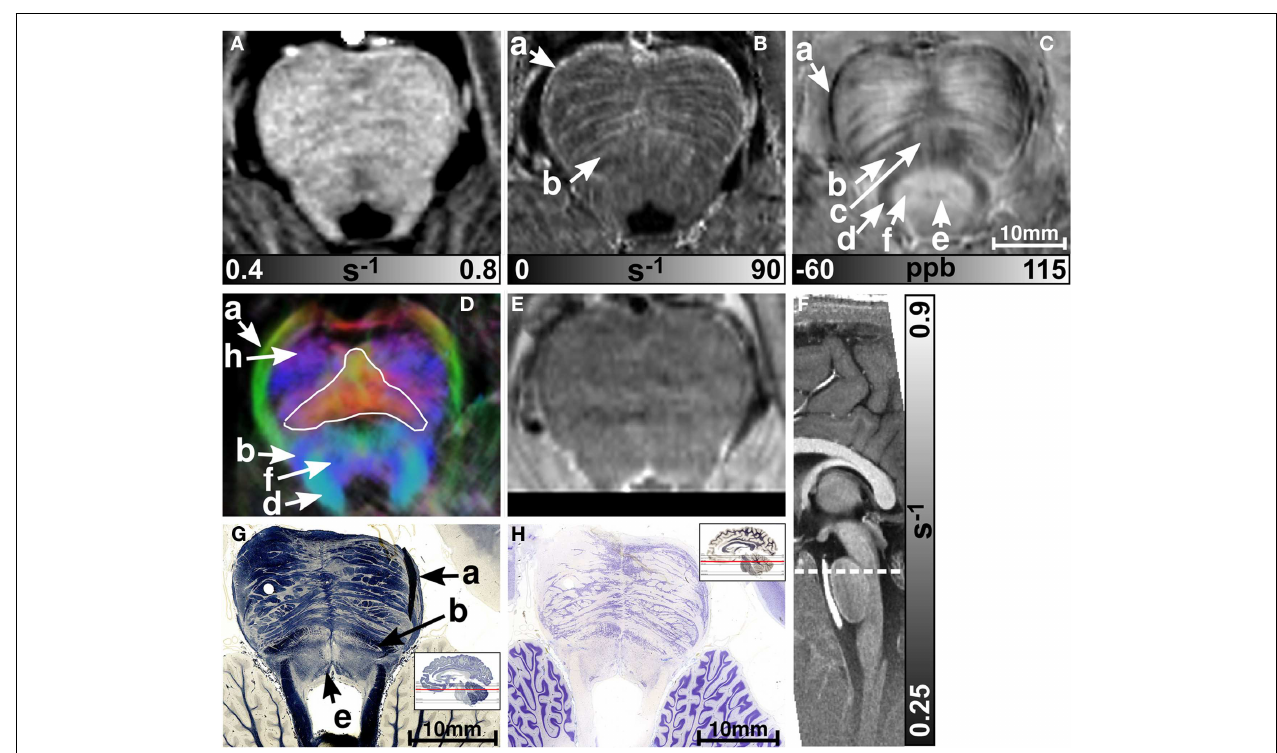
illustrated in (G) and (H) , respectively.The arrows in the images indicate: , and susceptibility FIGURE 3 | Images of the rostral part of the pons . R 1 , R ∗ 2 (a) middle cerebellar peduncle, (b) medial lemniscus, (c) reticulotegmental maps as well as direction-encoded track-density (same color-encoding as in nucleus, (d) superior cerebellar peduncle, (e) medial longitudinal fasciculus, Figure 1 ; slightly distorted compared to the other axial image contrasts) and (f) central tegmental tract, and (h) corticospinal tract.The solid white outline in T 2 -weighted images of the same region are presented in axial orientation from (A–E) , respectively.The sectional plane of the axial images is indicated (D) indicates the pontocerebellar fibers. [The histological stains (G,H) were adapted with permission from http://www.brains.rad.msu.edu and by the dashed line overlaid on the sagittal R 1 map shown in (F) . Axial http://brainmuseum.org, supported by the US National Science Foundation.] histological sections from a different subject stained for myelin and cells are